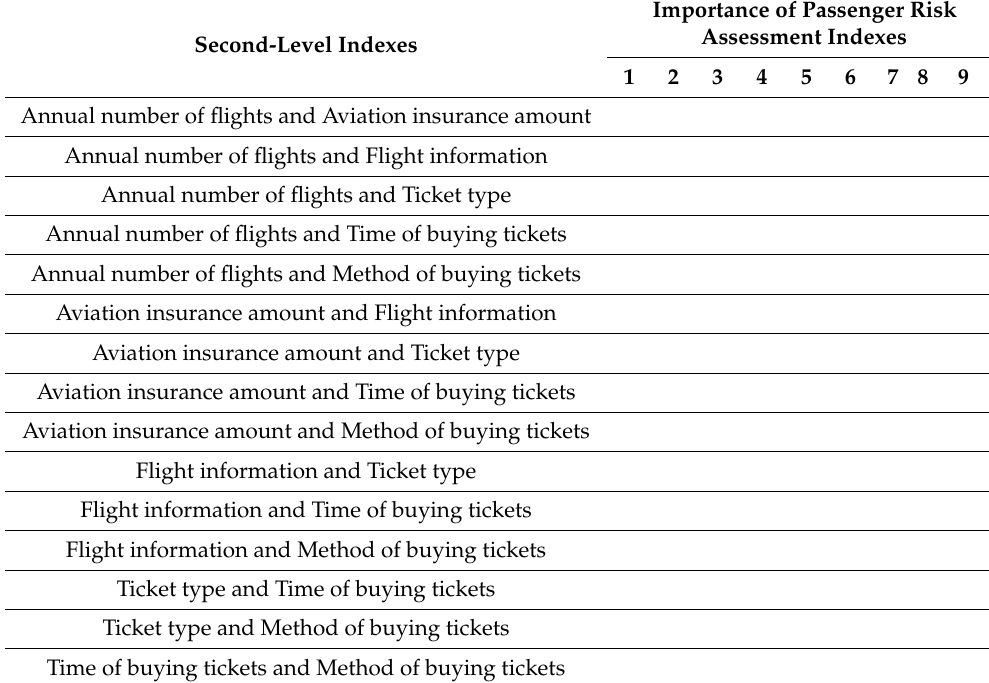
Table A6. Second-level indexes (civil aviation travel